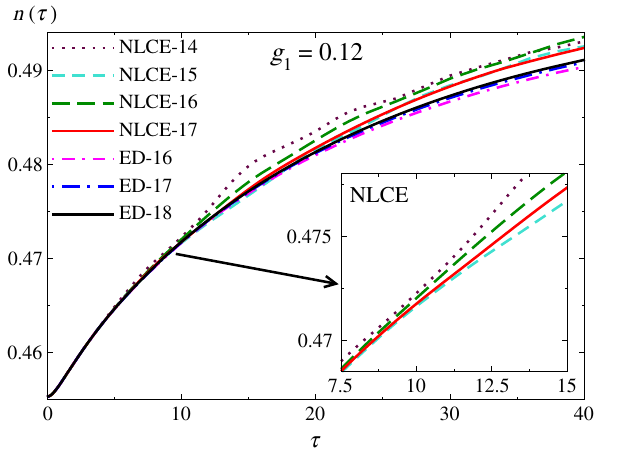
FIG. 10. Relative differences, defined in Eqs. (C1) – (C3), for g 1 ¼ 0 . 12 . The exact diagonalization results are obtained in chains with periodic boundary